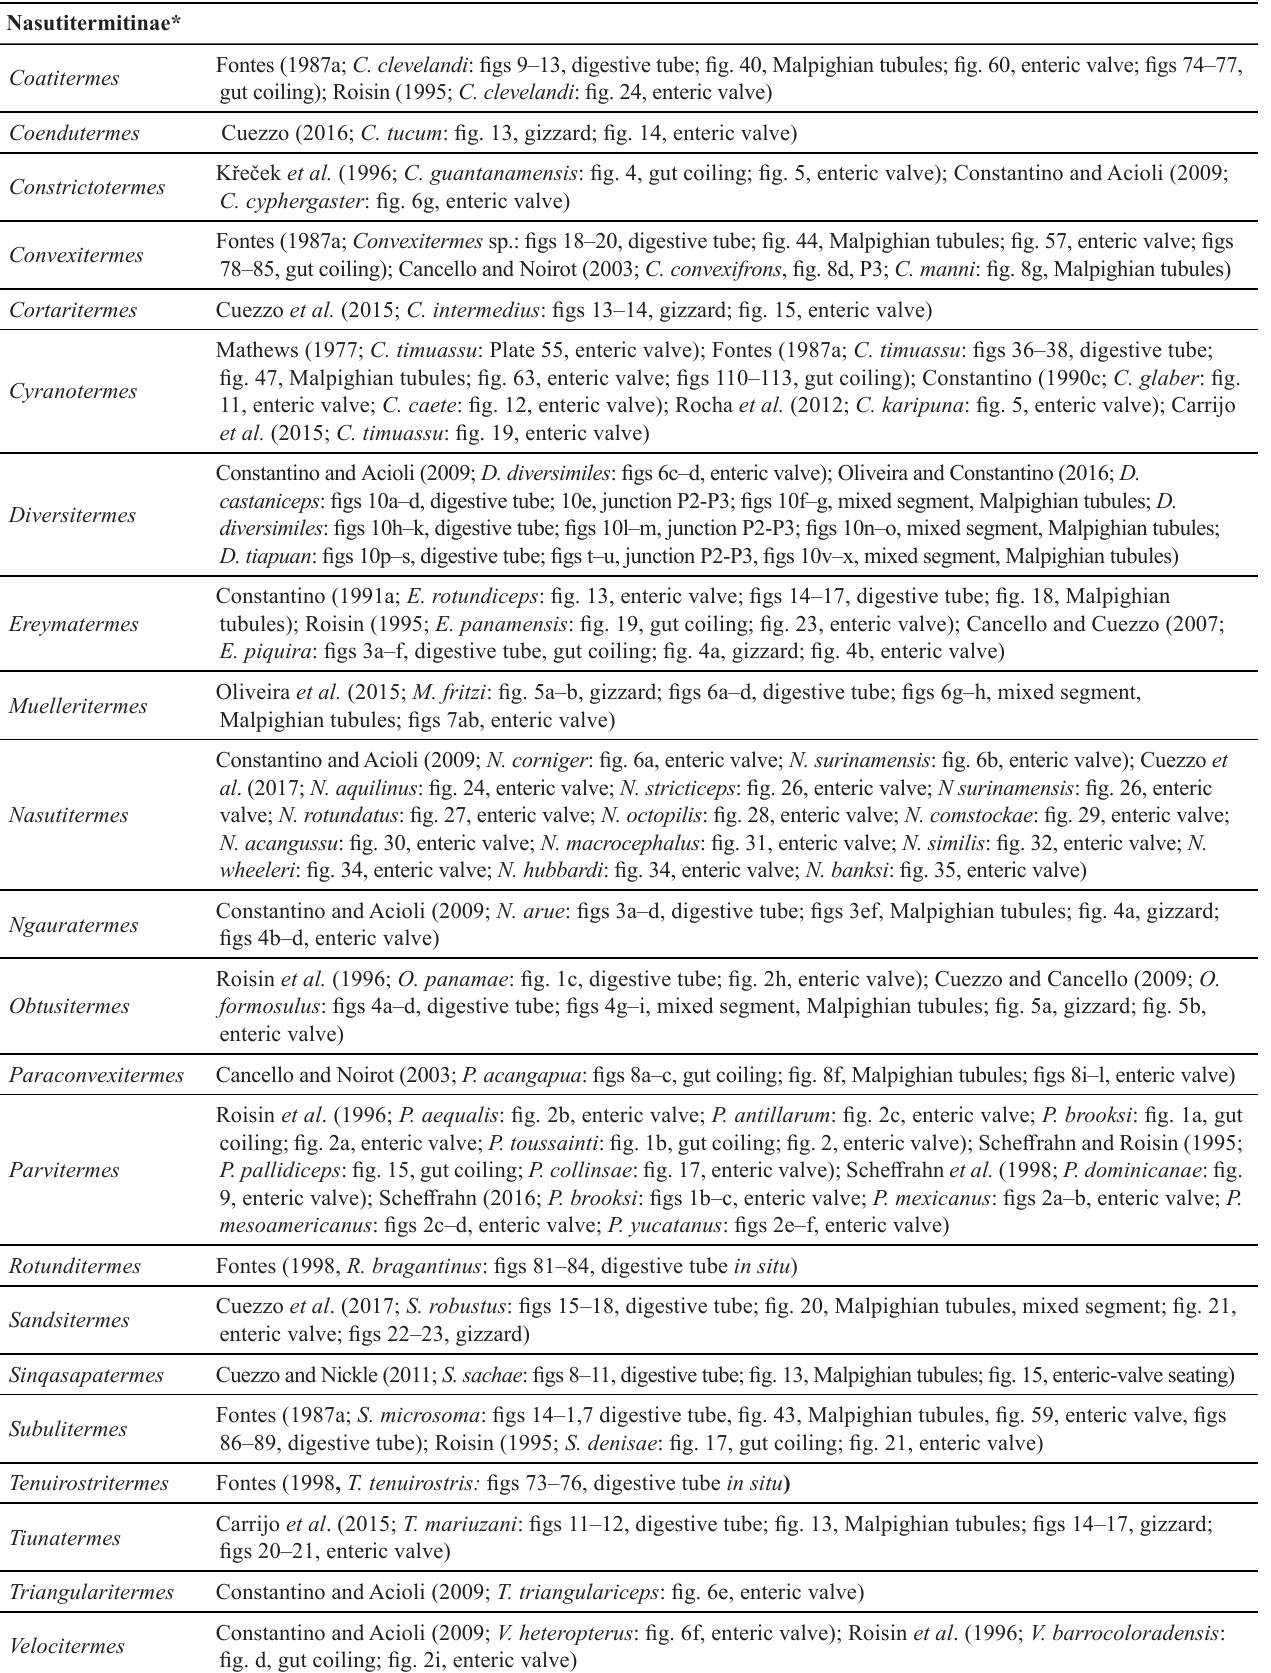
Table 1. List of taxonomic studies that treat the worker caste of Neotropical Termitidae genera. (Continuation)